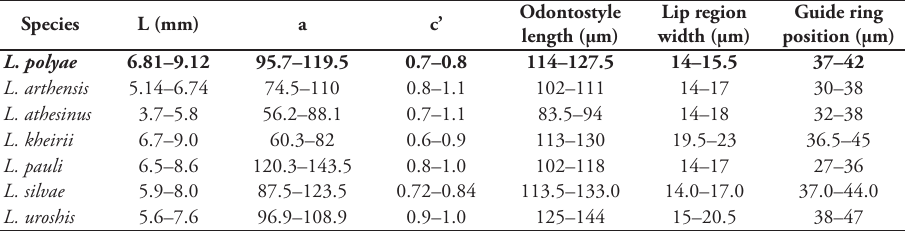
Table 3. Morphometric comparisons of Longidorus polyae sp. n. and related Longidorus spp. with similar morphological characters and DNA